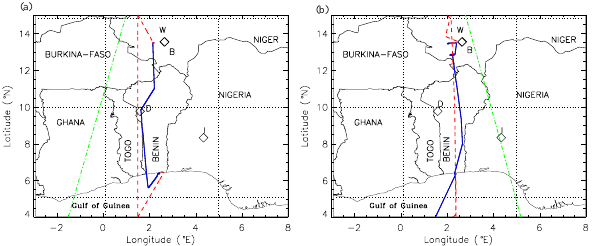
Fig.1. SAFIREF/F20(reddashedline)andATR-42(solidblueline)flighton13June (a) andand14June (b) 2006. Overlainarethe CALIPSOtracks(greendash-dottedlines)at01:37UTCon13Juneand14:00UTCon14June2006. I,D,BandWcorrespondtothe Fig. 1. SAFIRE F/F20 (red dashed line) and ATR-42 (solid blue locationoftheIlorin,Djougou,BanizoumbouAERONETstationsandWankamaAMMAstation,respectively. line) flight on 13 June (a) and and 14 June (b) 2006. Overlain are the CALIPSO tracks (green dash-dotted lines) at 01:37UTC on 13 June and 14:00UTC on 14 June 2006. I, D, B and W correspond to the location of the Ilorin, Djougou, Banizoumbou AERONET stations and Wankama AMMA station,